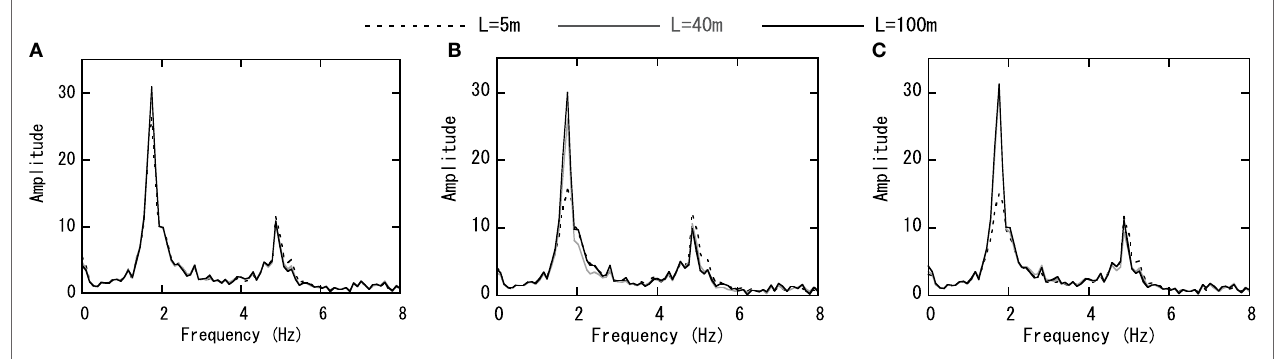
FigUre 15 | Transfer function (building top node/input motion) for X excitation . (a) TB. (B) VB without EF. (c) VB with